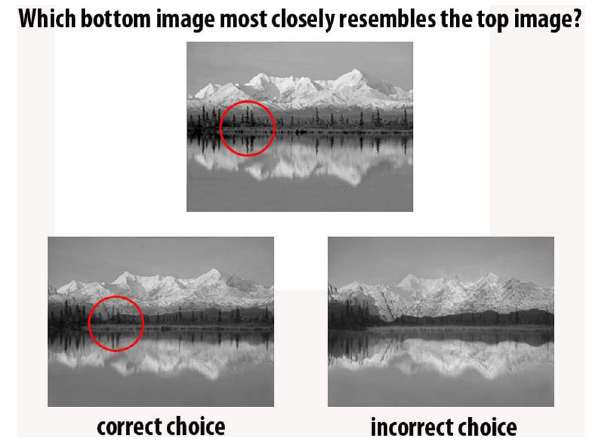
FIGURE 3 | Many of the discrepant findings relating to the role of the MTL in perception have used morphed stimuli [Levy et al. (2005); Lee et al. (2005c); Shrager et al. (2006); Clark et al. (2011); Kim et al. (2011)]. In this example participants indicated which of the two bottom images was most similar to the top image [paradigm used in Lee et al. (2005c); Shrager et al. (2006); Kim et al. (2011)]. Often, focusing on a single feature will provide sufficient information to solve the task, and thus, these morphed discriminations may not sufficiently stress processing the spatial conjunctions that comprise scenes (an example single feature is circled in red). In this instance, participants could merely determine which bottom image has darker trees along the shoreline, rather than processing the scene as a whole. Example from Lee et al.